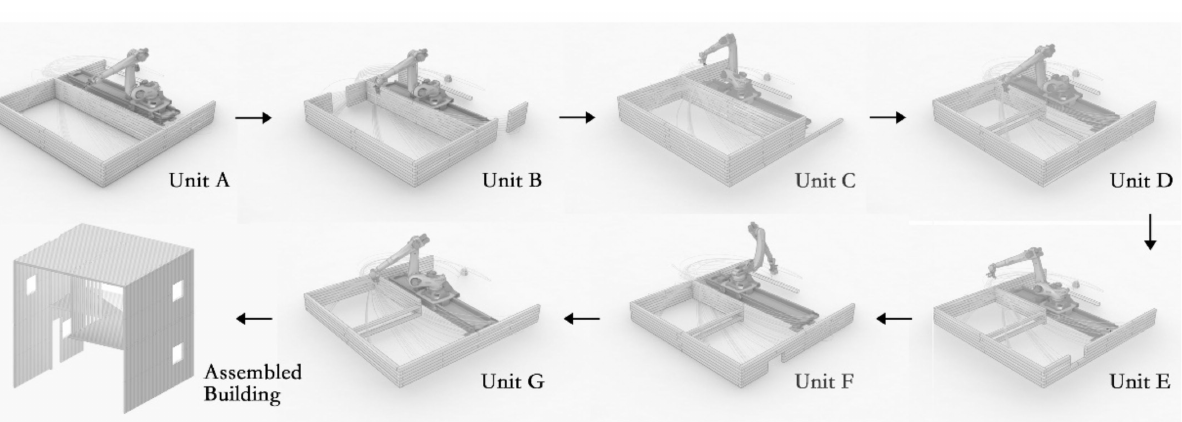
is completed, each unit is combined to form a complete building, as shown in Figure 8.